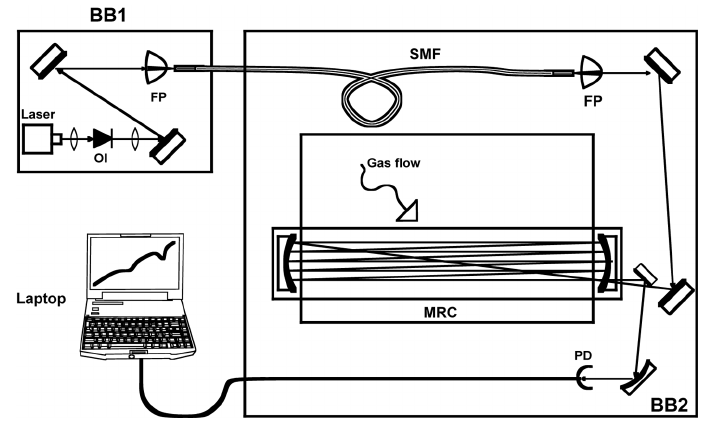
Fig. 1. Sketch of the experimental arrangement of the portable 2- µ m spectrometer. OI – Optical Isolator; SMF – Single Mode Fiber; FP – Fiber Port; MRC – Multiple-Reflection Cell; PD – photodiode; BB1 – breadboard 1 (60 × 60 cm 2 ); BB2 – breadboard 2 (70 × 40 cm 2